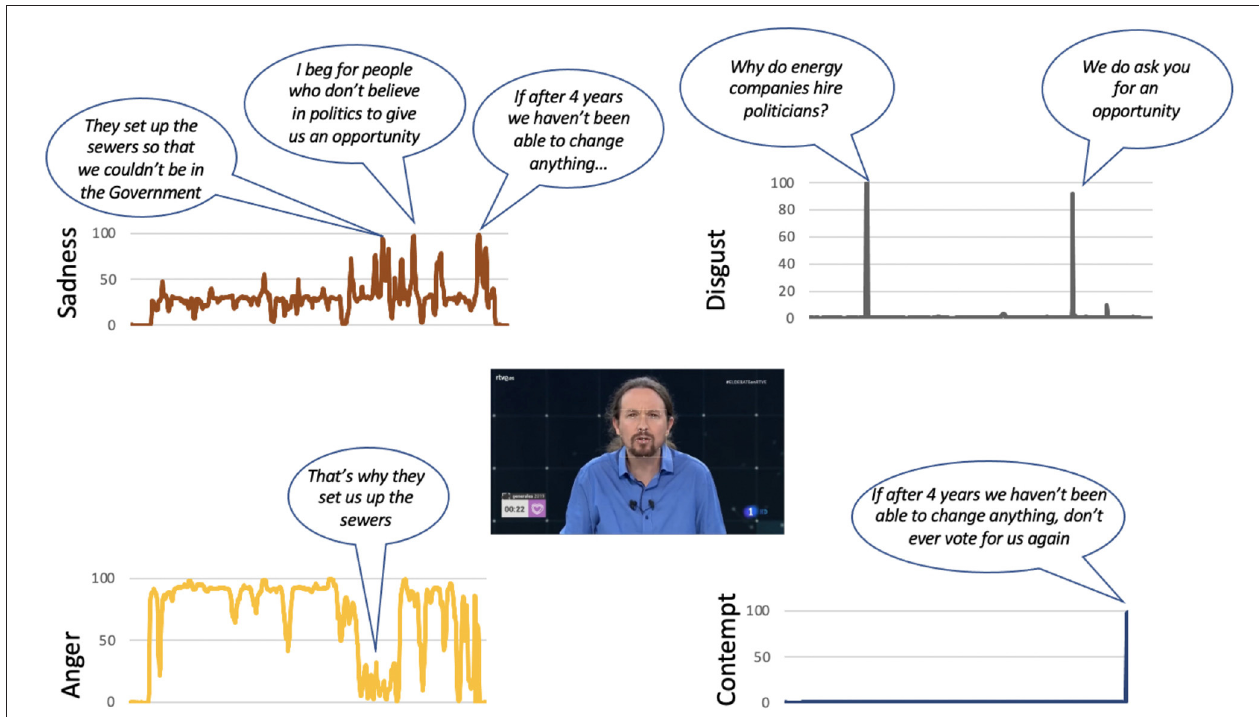
FIGURE 6 | The main phrases of Pablo Iglesias’s speech during the golden minute associated with certain